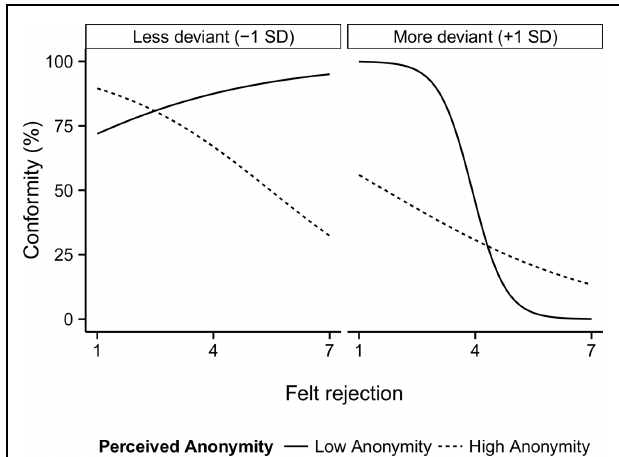
FIGURE 1 | Plot of the predicted values from the three-way Felt Rejection × Anonymity × Level of Deviance interaction on conformity. The panels show the differences between relatively less deviant and relatively more deviant group members. The line types are based on the anonymity manipulation check, and show the different relation between felt rejection and conformity depending on the subjective anonymity of the decision (low and high anonymity, or 2 and 6 on the 7-point scale,